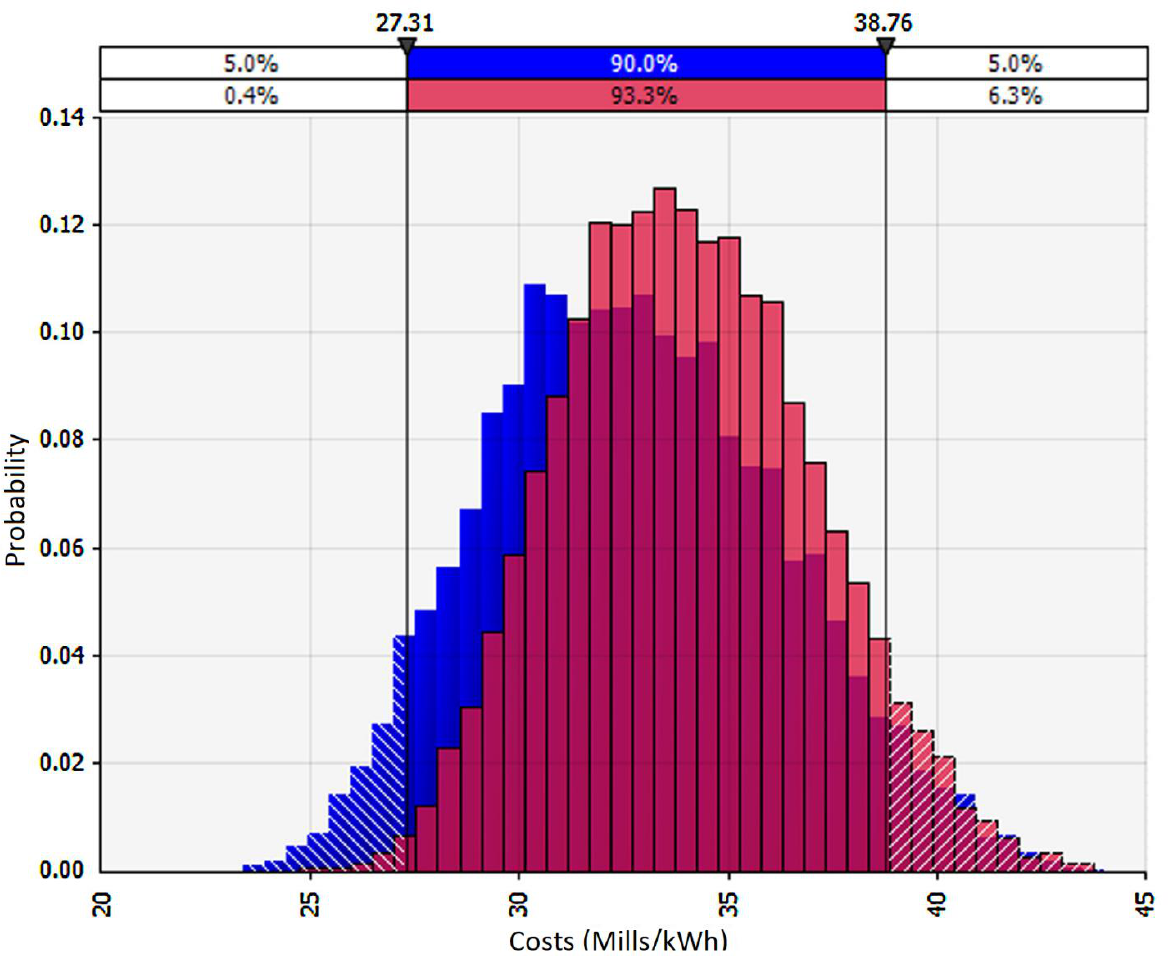
Figure 11. Probability functions for LCOE estimates for OTC and closed fuel cycle (PWR and SFR fuels with pyroprocessing) compared [39].